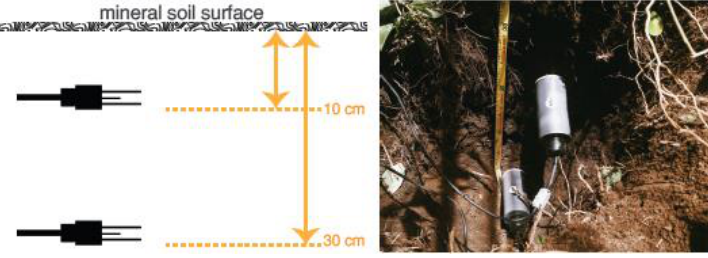
Figure 2. Logging system of sensors to measurement soil water content and soil temperature.